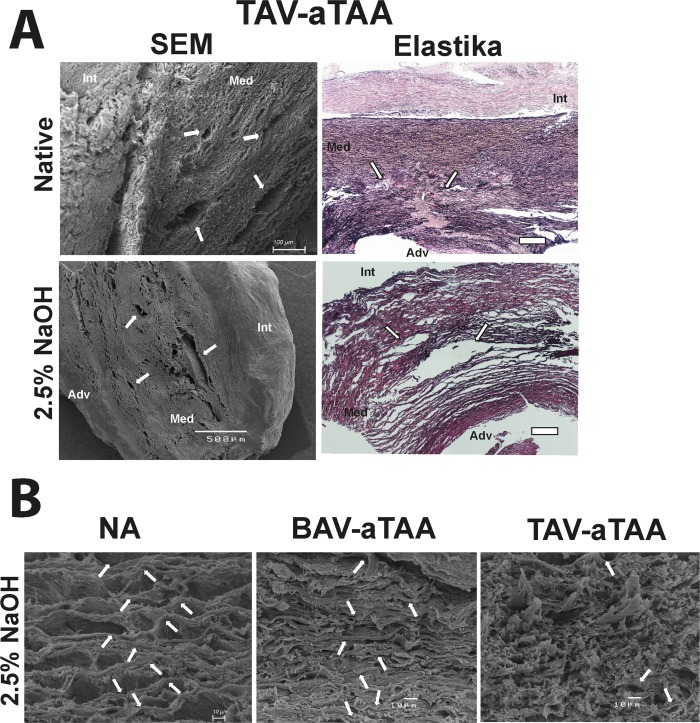
Comparison of SEM pictures with histological stainings and higher magnification pictures to show elastic fiber sheets after decellularization.In (A) the focal medial degeneration (white arrows) of TAV-aTAAs is depicted by SEM images as well as in Elastika van Gieson stained tissue. Scale bar in the Elastika van Gieson staining represents 250μm. (B) Representative SEM images of NA and aneurysmal tissue after decellularization (white arrows are indicating elastic fiber disks). Int = intima; Med = media; Adv = adventitia.